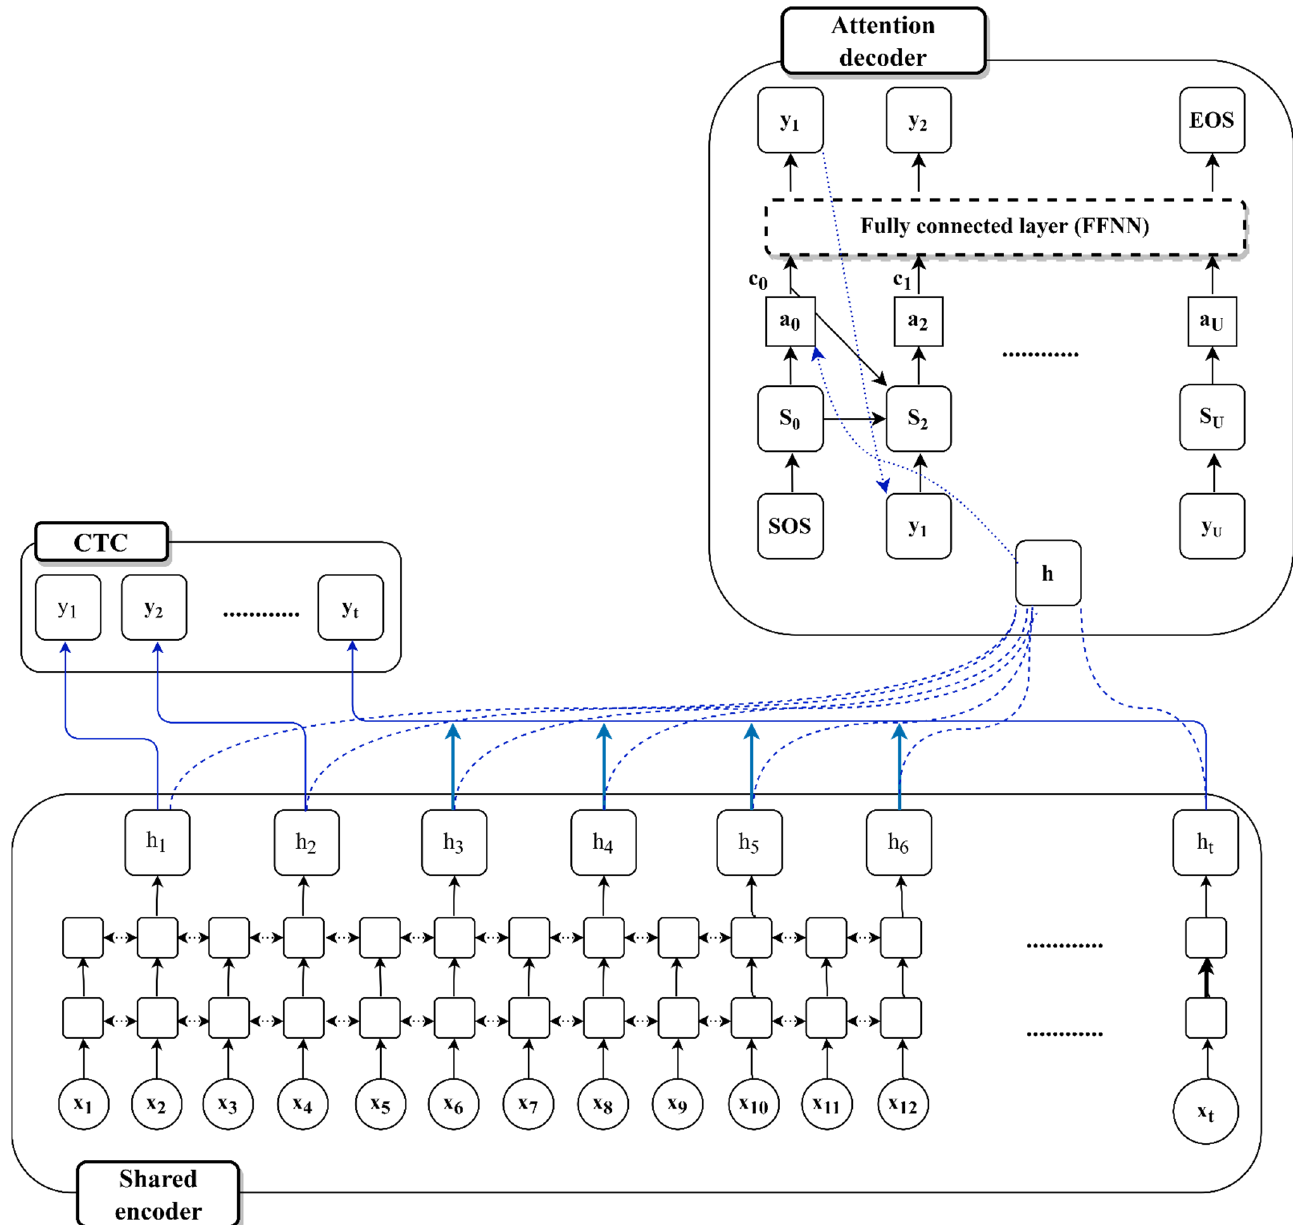
Figure 5. A network combining connectionist temporal classification (CTC) and attention-based voice recognition. The shared encoder transforms the input x into the encoder vector h as the output. Both the CTC and the attention models are trained on the common encoder. The probability distribution for the output y is generated using CTC and attention.